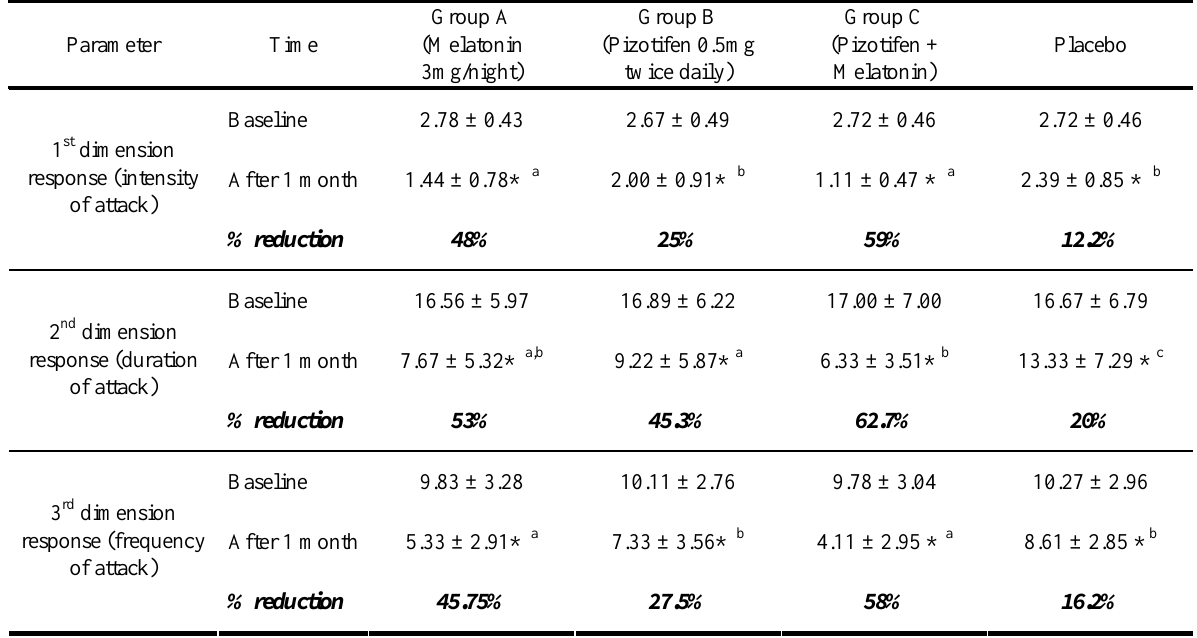
Table (1): Effect of treatment with melatonin, pizotifen and their combination on migraine paramete rs Parameter